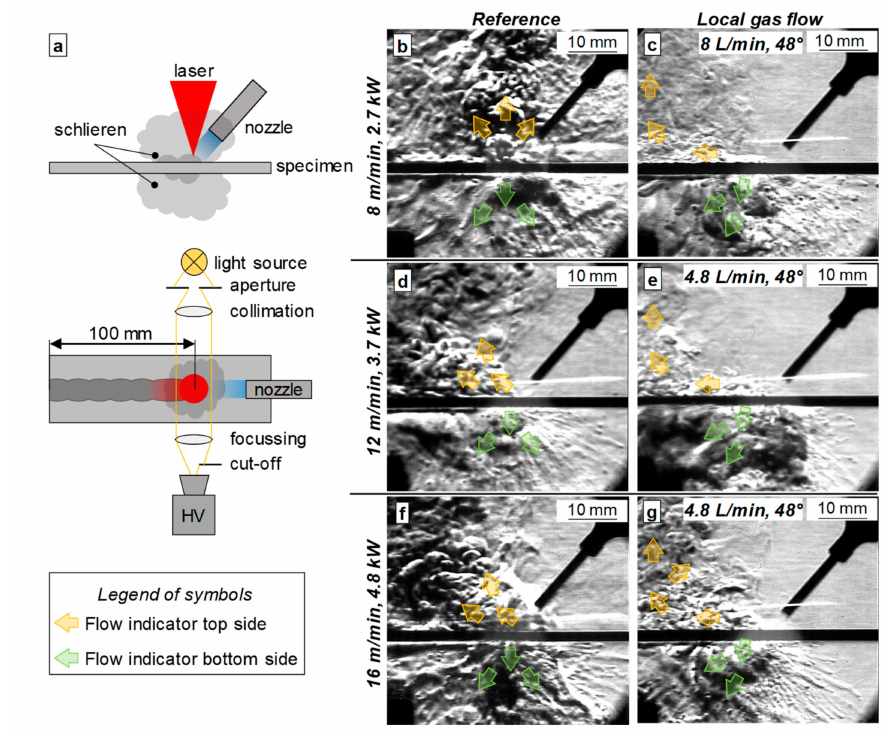
Figure 6. ( a ) Schematic of used schlieren setup; ( b – g ) Schlieren records of the reference and gas-assisted process (argon) depending on welding